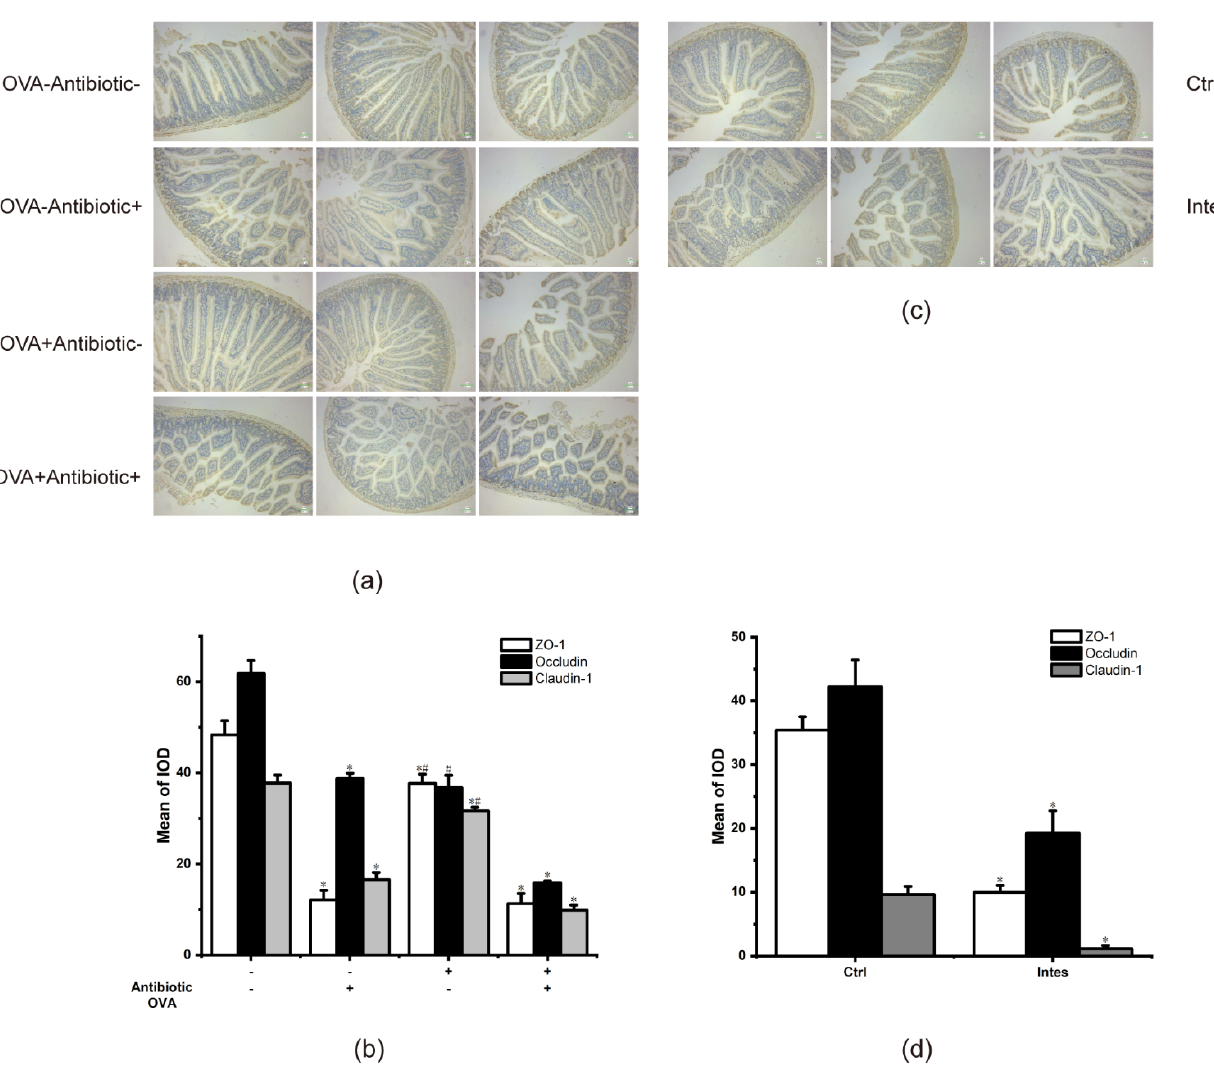
Figure 9. Dysbiosis of gut microbiota reduces tight junction proteins in jejunum tissues and increases zonulin in mice serum. ( a ) Immunohistochemical pictures and quantitative analysis of TJs in the food allergy–gut microbiota dysbiosis model. ( b ) Column graphs represent the quantitative result of (a). ( c ) Immunohistochemical pictures and quantitative analysis of TJs in the gut microbiota dysbiosis model. ( d ) Column graphs represent the quantitative result of (c). ( e ) Zonulin content in mice serum in the food allergy–gut microbiota dysbiosis model. ( f ) Zonulin content in mice serum in